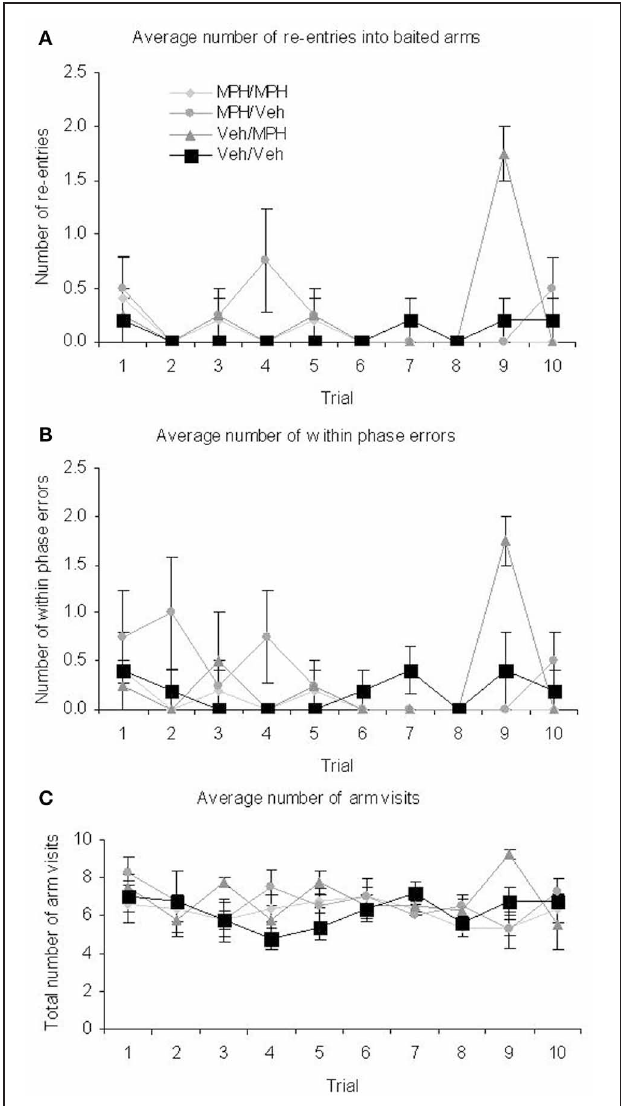
FIGURE 7 | At the 6h delay DSWT there were significant interaction effects between trial and treatment on (A) baited re-entry (B) total arm visits (C) within phase errors. Although interpretation of the interactions displayed in (A) and (C) is difficult due to the small numbers involved, restricted ANOVA suggested that the interaction they are all due to increased scores recorded for the Veh/MPH group on trial 9. All graphs show mean ±